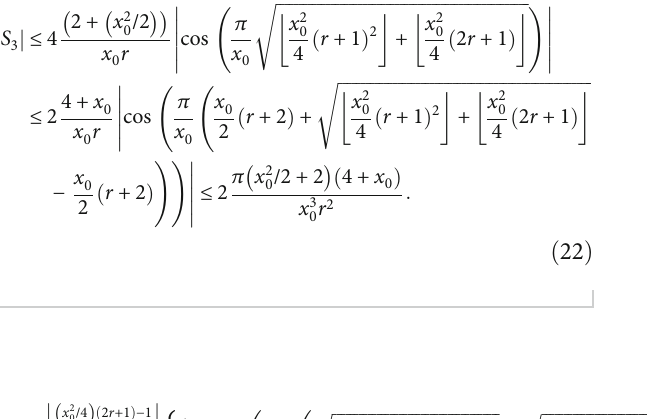
ffiffiffiffiffiffiffiffiffiffiffiffiffiffiffiffiffiffiffiffiffiffiffiffiffiffiffiffiffiffiffi x 0